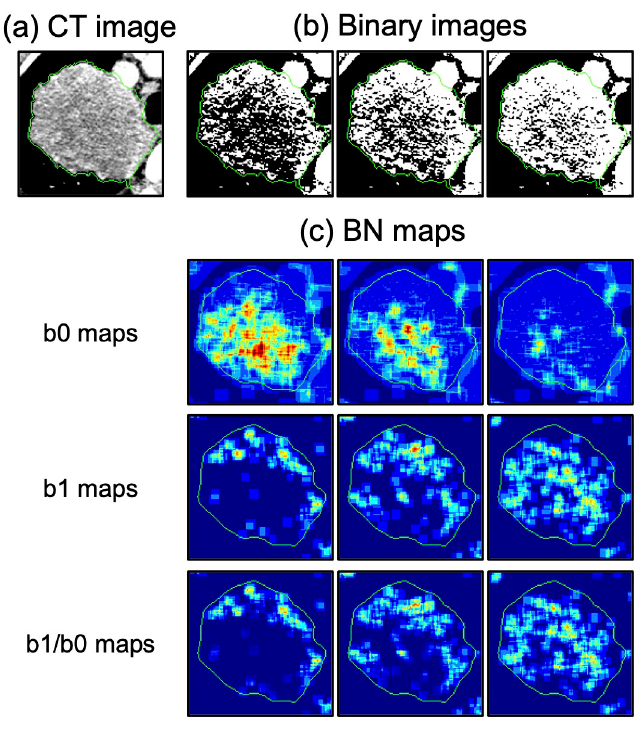
Fig 4. Representative images of (a) computed tomography (CT) images, (b) binary images, and (c) Betti number (BN) maps.